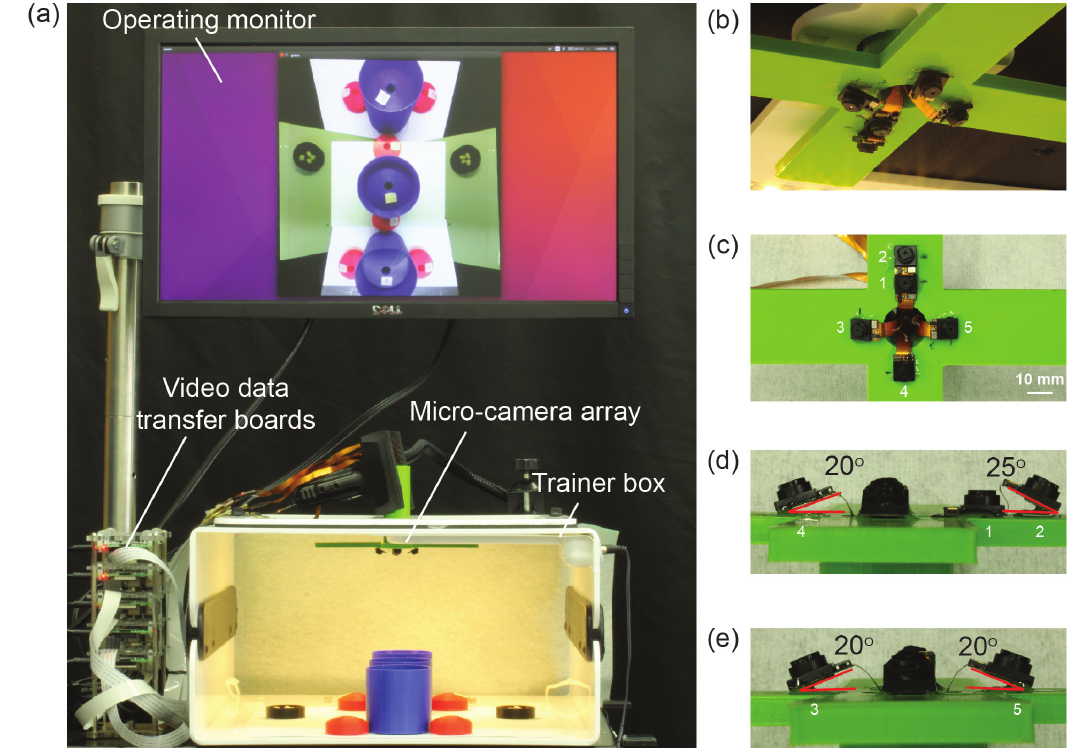
Figure 2. Micro-camera Array Visualization System: ( a ) The micro-camera array is inserted into the trainer box. The operating monitor shows the stitched video that used video data from the micro-camera array transferred through the video data transfer boards. ( b ) The miniaturized cameras are placed on a 3D printed scaffold to allow for the use of the visualization software during testing. The camera position has been chosen to maximize the coverage of the bottom of the trainer box while minimizing parallax artifacts in the visualization. ( c ) Front view of the micro-camera array with numbers indicating camera position. ( d , e ) Side view of the micro-camera array with numbers indicating camera position and tilting